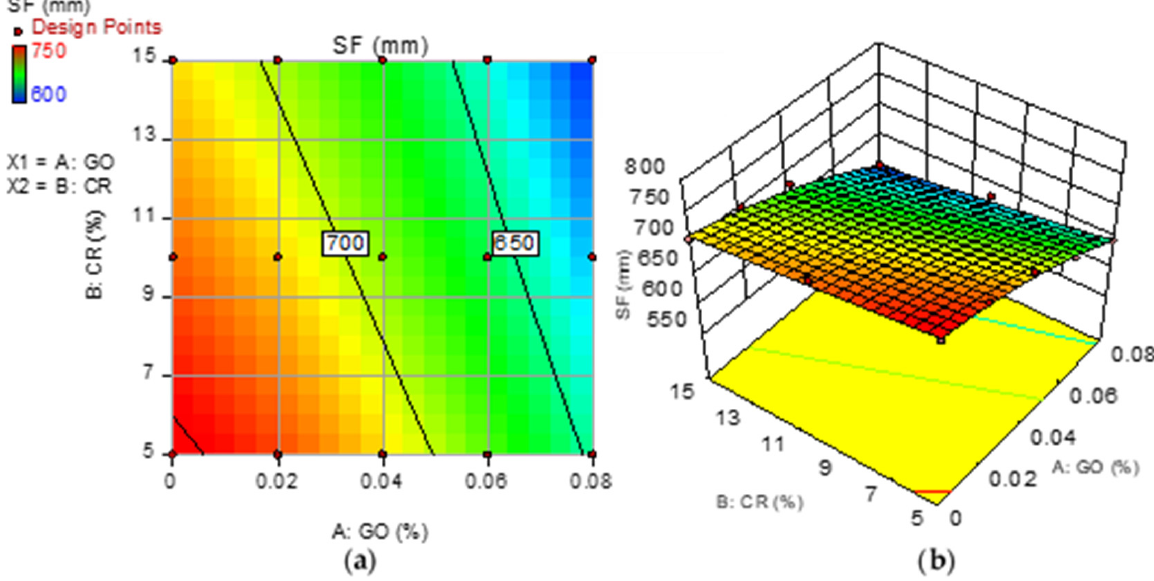
Figure 9. ( a ) 2D contour plot and ( b ) 3D response surface diagram for SF.